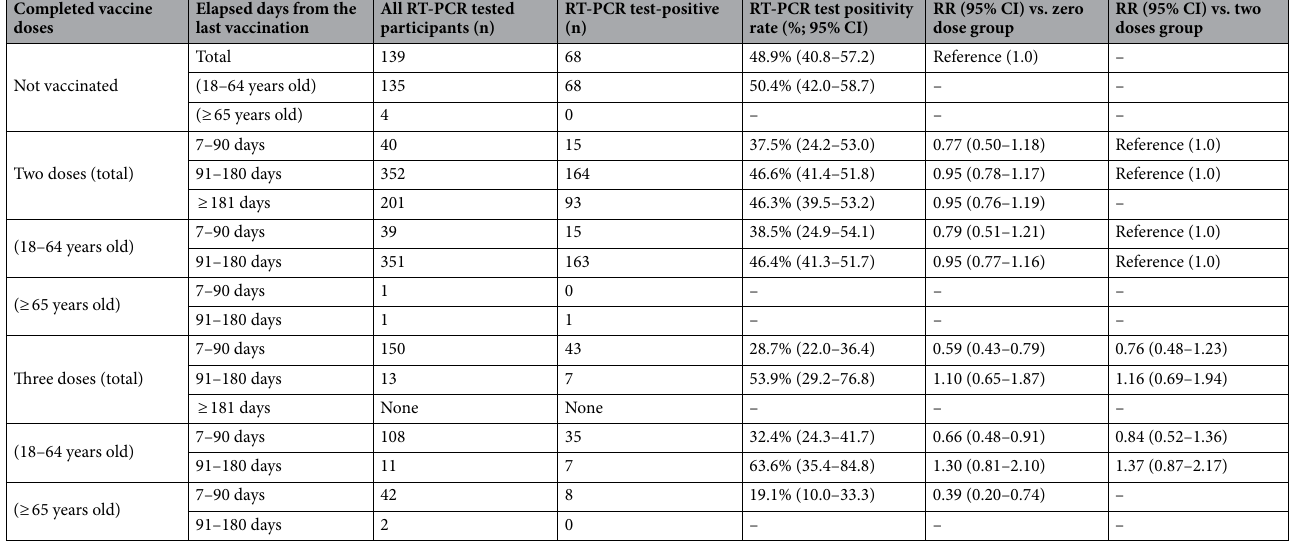
Table 1. Sensitivity analysis of RT-PCR test-positive rate after close contact by the elapsed days from the last vaccination and age groups. RT-PCR test positivity rate after close contact with COVID-19 cases among adults